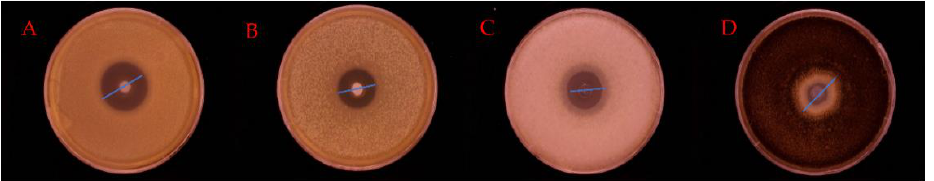
Figure 13. Inhibition circle size of different strains treated with SLN-CA; ( A ) for Staphylococcus aureus . ( B ) Escherichia coli . ( C ) Creeping Rhizopus . ( D ) Aspergillus niger . Table 2. SLN-CA antibacterial ability. Strain